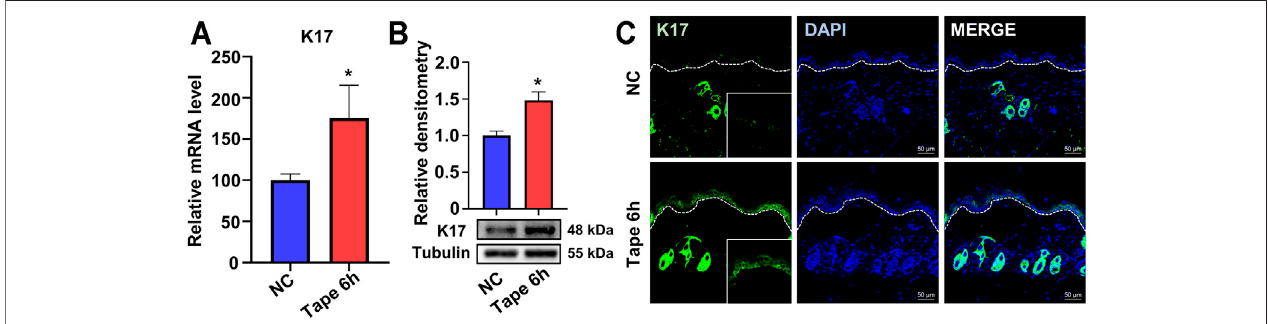
FIGURE 1 | The expression of keratin 17 was upregulated after acute epidermal disruption in wild-type mice. (A) The mRNA levels of keratin 17 ( Krt17 ) in the epidermis 6 h after tape stripping as detected by real-time quantitative PCR (RT-qPCR). (B) The protein levels of K17 as determined by Western blot; quanti fi cation was based on three independent experiments. (C) Immuno fl uorescence staining for K17 (green). * p < 0.05.